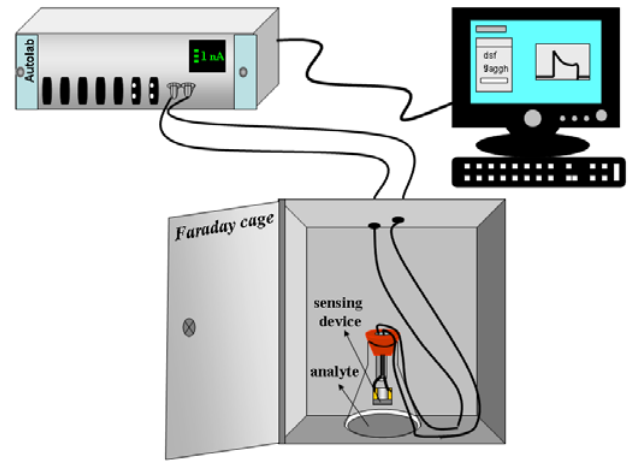
Figure 4 . Schematic of sensor set up. The sensing device made up of MWCNTs/Nylon-6 nanofibers composite has been attached in a conical flask with a rubber stopper and then connected to the Autolab (model PGSTAT 30). The sensing set up has been enclosed in a Faraday cage to ensure a protected